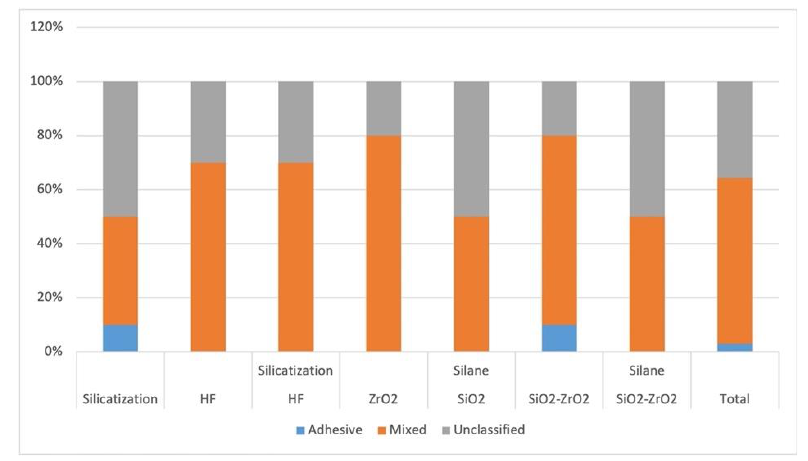
Figure 5. Representative images of failure patterns after the shear test: ( A ) unclassified failure; ( B ) mixed failure; ( C ) adhesive failure.